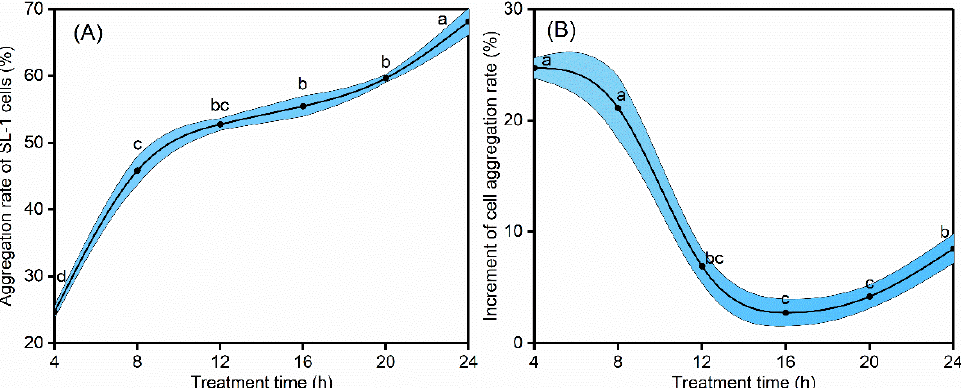
Figure 3. Aggregation rate of SL-1 cells ( A ) and increment of cell aggregation rate ( B ) within 24 h after treatment with 0.2 µg/mL of rotenone. Data are presented as mean ± S.E ( n = 3). Different letters indicate significant differences in the aggregation rate of SL-1 cells or increment of cell aggregation rate in different time periods at p < 0.05 level based on Tukey’s HSD test.